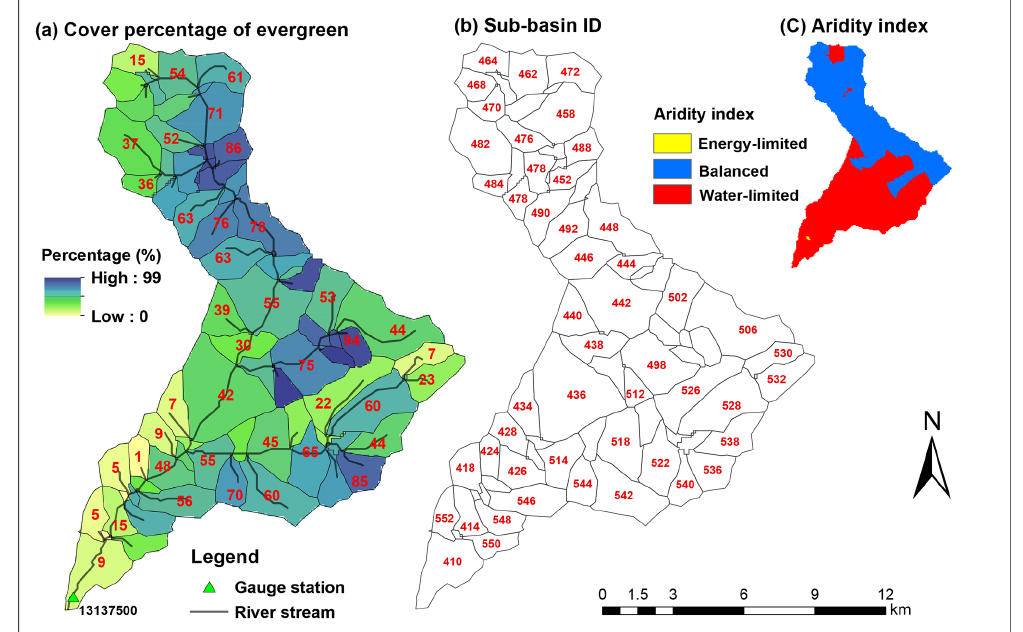
Figure 3. Evergreen forest cover percentage and ID of each sub-basin in Trail Creek, and long-term aridity index for this watershed. Aridity index is defined as annual mean potential evapotranspiration (PET)/precipitation ( P ) from 38 years of data (see Sect. 3.4); PET/ P > 2 is water limited, PET/ P < 0 . 8 is energy limited, and PET/ P between 0.8 and 2 is balanced. Recall that only evergreen forest trees are attacked during beetle